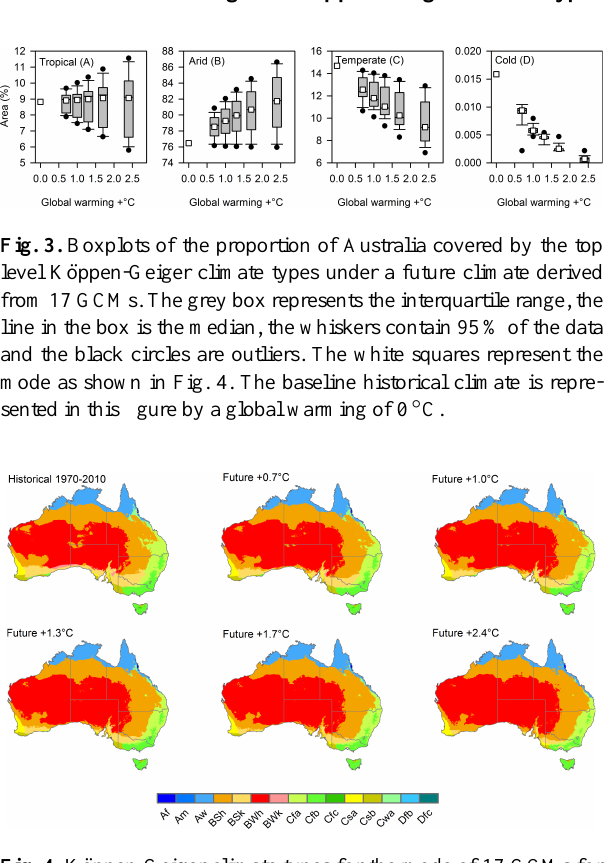
Fig. 4. K¨oppen-Geiger climate types for the mode of 17 GCMs for 5 global warming scenarios (historical baseline period is included for